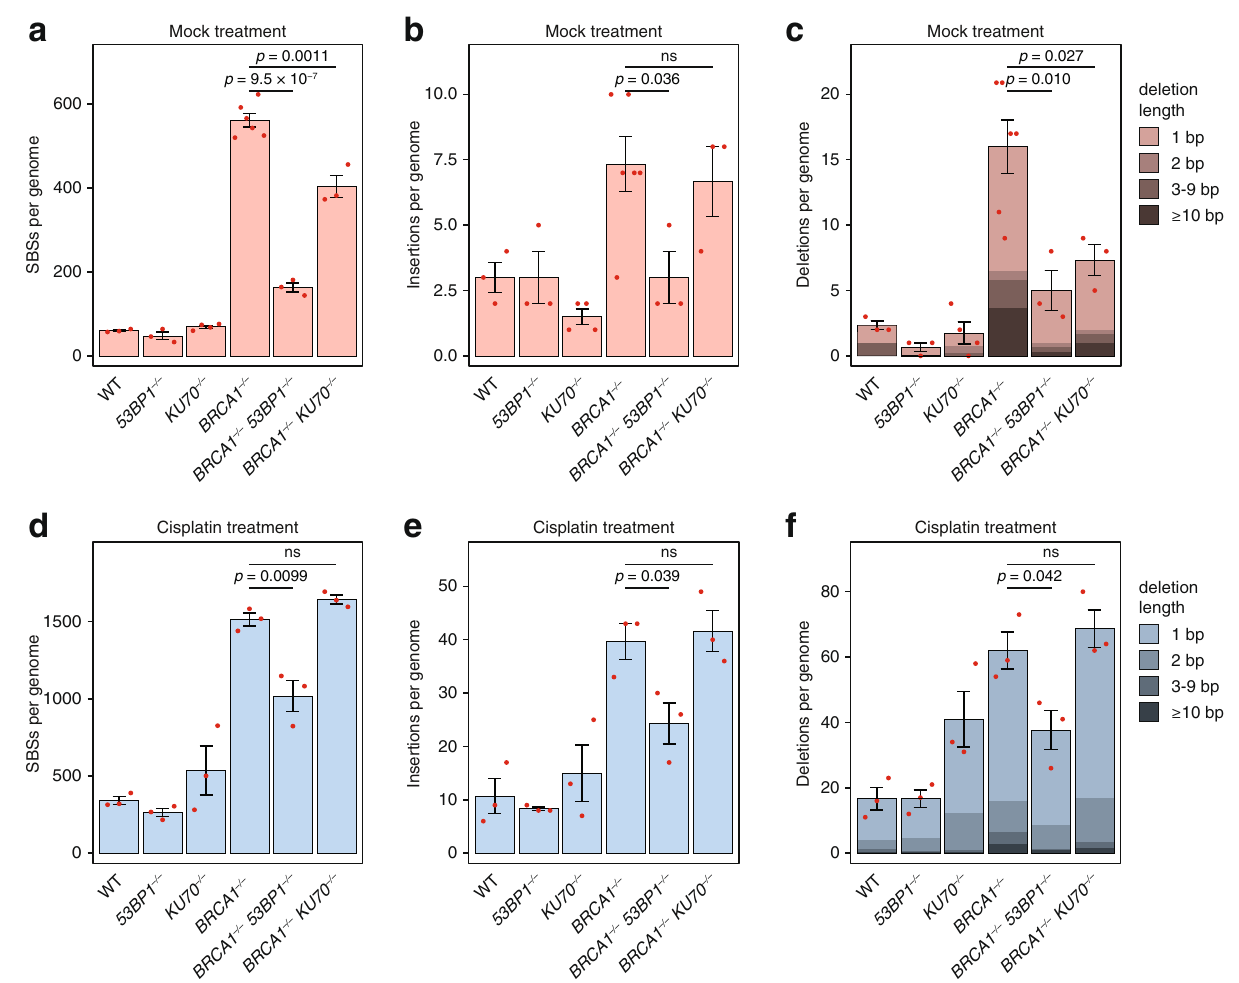
Fig. 3 Mutagenesis in BRCA1 de fi cient cells is regulated by 53BP1. a-c The mean number of newly arising SBS (single base substitution, a ), insertion ( b ) and deletion ( c ) mutations detected in DT40 cell clones of the indicated genotypes following 50 days of culturing an ancestral clone (mock treatment). d – e The mean number of newly arising SBS ( d ), insertion ( e ) and deletion ( f ) mutations detected in DT40 cell clones of the indicated genotypes following 50 days of culturing that included four 1-h treatments at weekly intervals with 10 μ M cisplatin. A sub-classi fi cation of deletion events according to size is shown by shading in ( c , f ). Error bars indicate SEM of the column totals, individual values are also shown with red symbols. The signi fi cance of tested differences is shown (ns not signi fi cant, unpaired two-sided t -test, data were derived from genome sequencing of biologically independent samples, see Supplementary Data 4 for sample sizes). Source data are provided as a Source Data fi